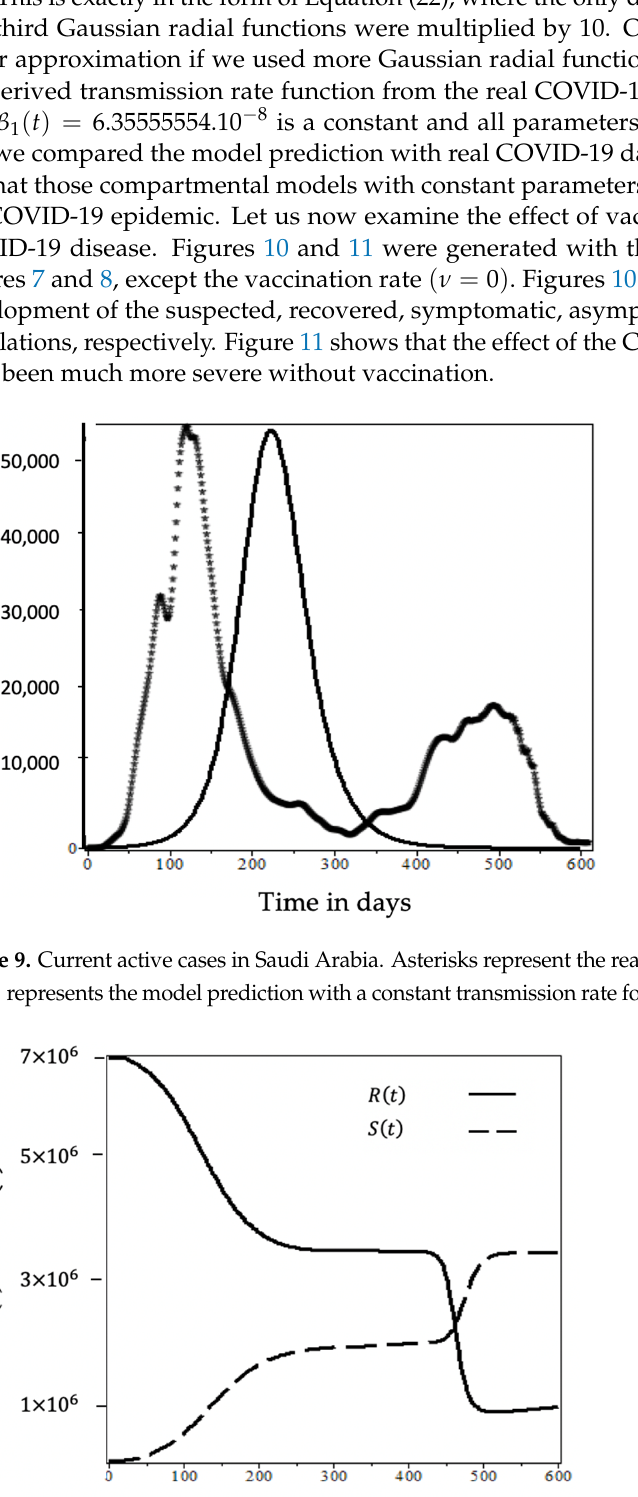
Figure 11. Model prediction of current active cases without vaccination: continuous line 𝑌(𝑡) , dashed line 𝑁(𝑡) , and dashed/dotted line 𝐻(𝑡).